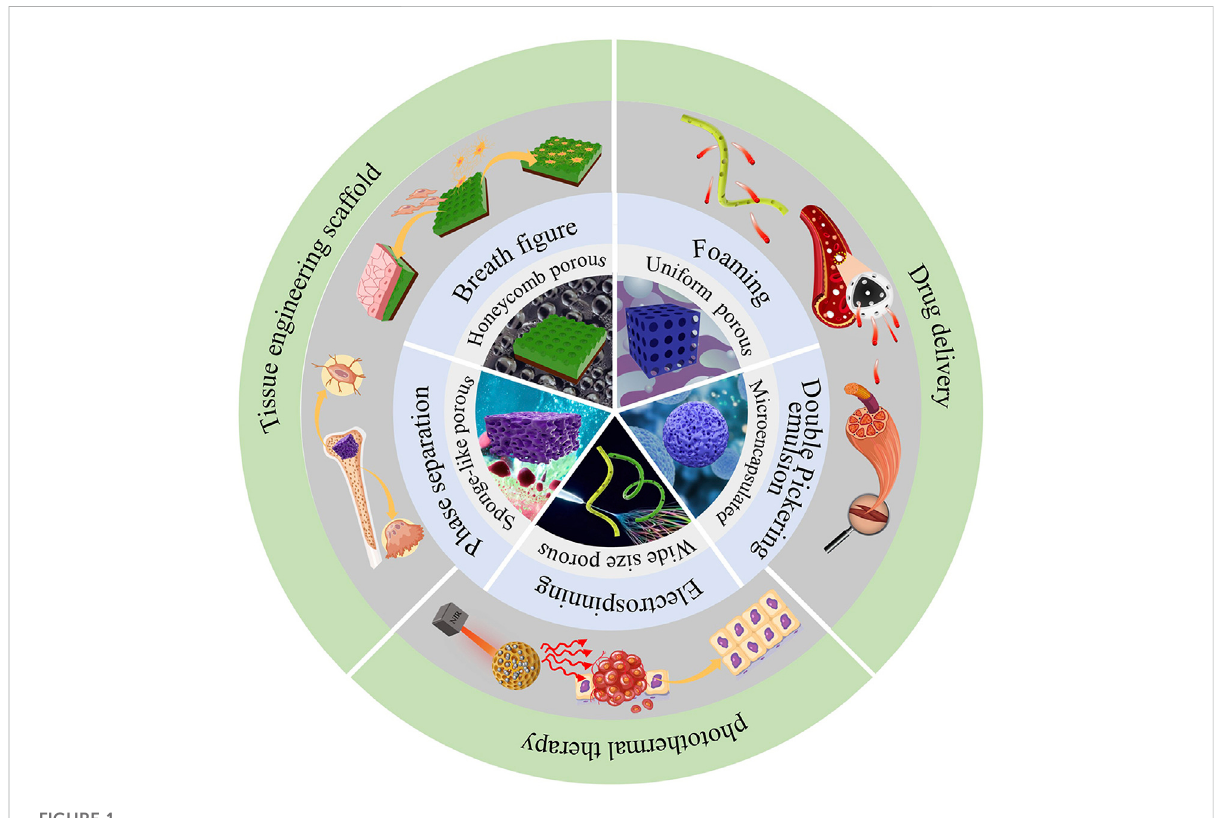
FIGURE 1 Fabrication methods and biomedical applications of self-assembled